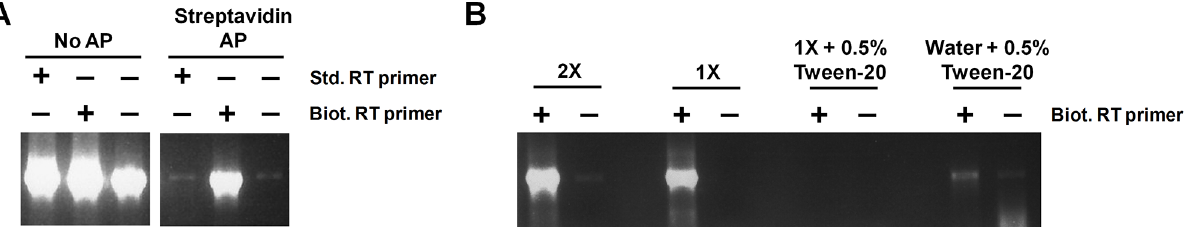
Fig 5. Affinity purification of cDNAs primed with biotinylated RT primers circumvents nonspecific priming during RT. (A and B) RNA extracted from a high titer stock of cell-free LCMV virions was subjected to standard RT-PCR to detect S segment vRNA using the RT primer S 2865- and PCR primers 1856+ and 2628- (note that the sequence for primer 1856+ is listed in the Methods). In panel (A), three RT conditions were tested. The first RT condition featured a standard RT primer, the second had a biotinylated primer, and the third had no RT primer, as indicated. A portion of each reaction was subjected to affinity purification using streptavidin magnetic beads and then both the input and streptavidin-purified cDNAs were subjected to PCR. In panel (B), two RT conditions were tested: one with a biotinylated RT primer and the other without an RT primer. In an attempt to eliminate nonbiotinylated cDNAs from nonspecifically binding to streptavidin beads, a panel of four wash buffers (the 2X wash buffer from the Dynabeads kilobaseBINDER Kit, a 1X dilution of this buffer alone or containing 0.5% Tween 20, or water containing 0.5% Tween 20) were used during affinity purification. Following affinity purification, the captured cDNAs were subjected to